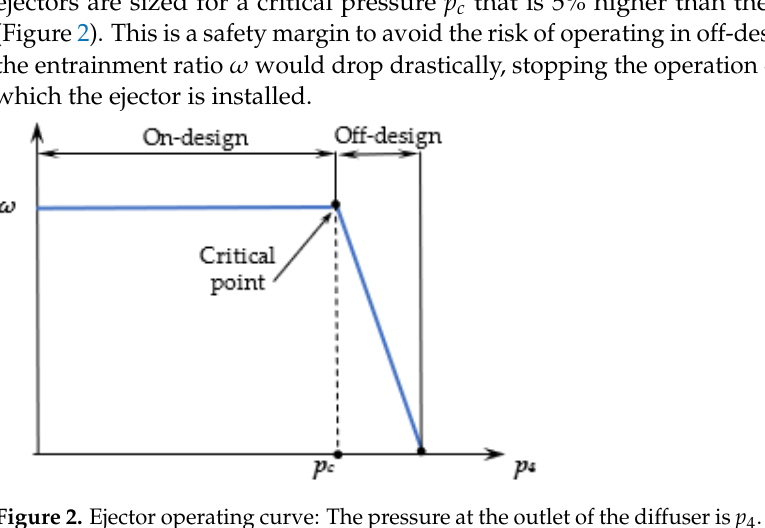
Figure 2. Ejector operating curve: The pressure at the outlet of the diffuser is p 4 . To operate correctly—that is, keeping the entrainment ratio constant and equal to the design value (on-design)—the pressure p 4 must be equal to or lower than the critical pressure p c .